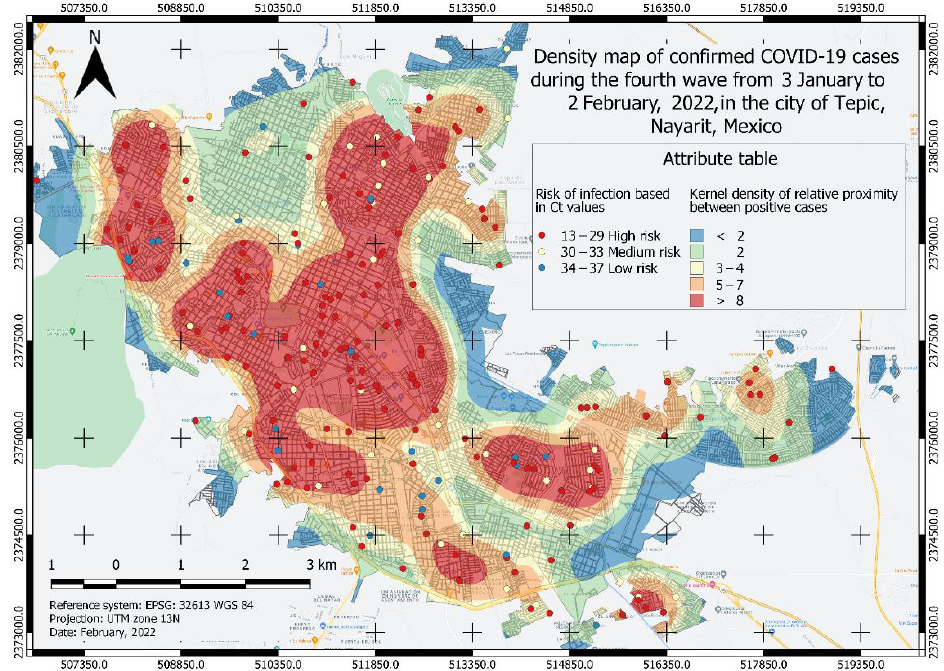
Figure 5. Density map of confirmed COVID-19 cases in the fourth wave from 3 January to 2 February 2021, in the city of Tepic, Nayarit, Mexico. The different areas classified by color indicate the level of risk of probability of contagion of the COVID-19 disease and each point corresponds to a confirmed case categorized by its Ct value.